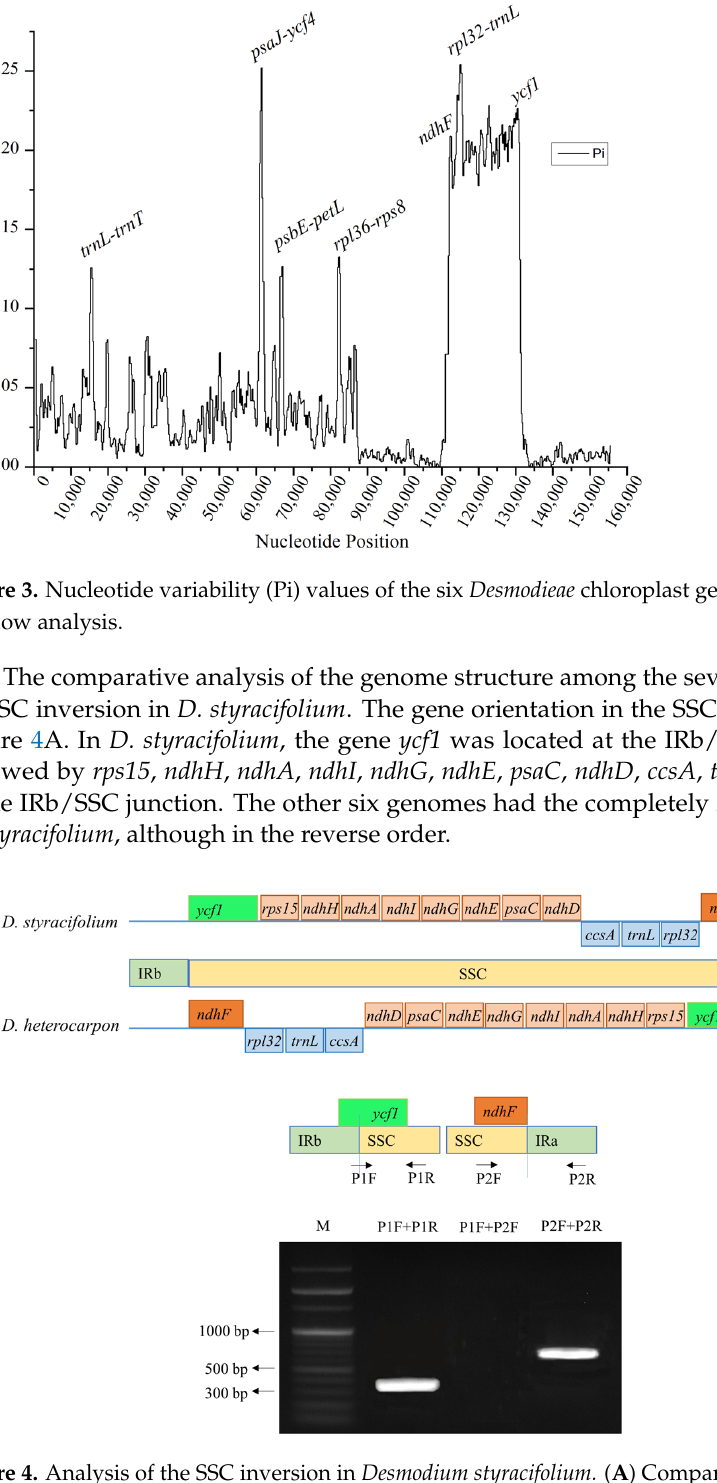
Figure 4. Analysis of the SSC inversion in Desmodium styracifolium. ( A ) Comparison of the gene order in the SSC region of D. styracifolium and D. heterocarpon . ( B ). Primer design for the PCR to amplify the IR/SSC junction regions in D. styracifolium . Two pairs of primers, primer 1 (P1F/P1R) and primer 2 (P2F/P2R) are designed to amplify the IRb/SSC junction. Primer P1F is located at the IRb/SSC boundary, while P1R and P2R are in ycf1 and ndhF, respectively, which are in the SSC region. ( C ) PCR amplification of the IR/SSC junctions in D. styracifolium . M: PCR 100 bp Low Ladder.